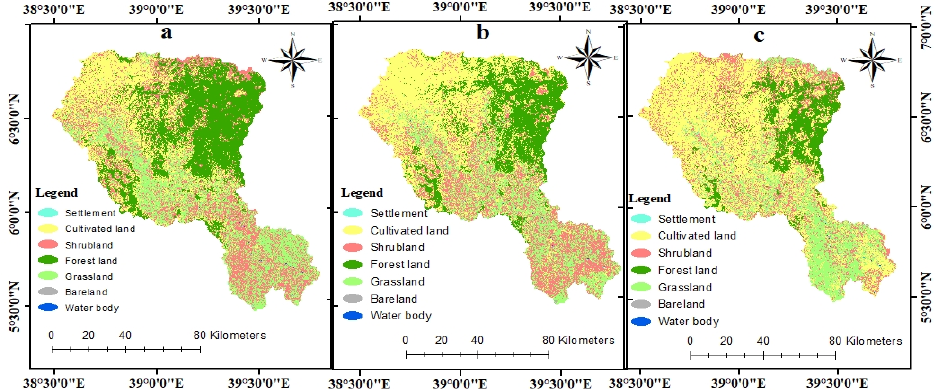
Figure 4. LULC in 1986 ( a ), 2001 ( b ), and 2016 ( c ) periods of the study basin. Table 2. LULC in the years 1986, 2001, and 2016.